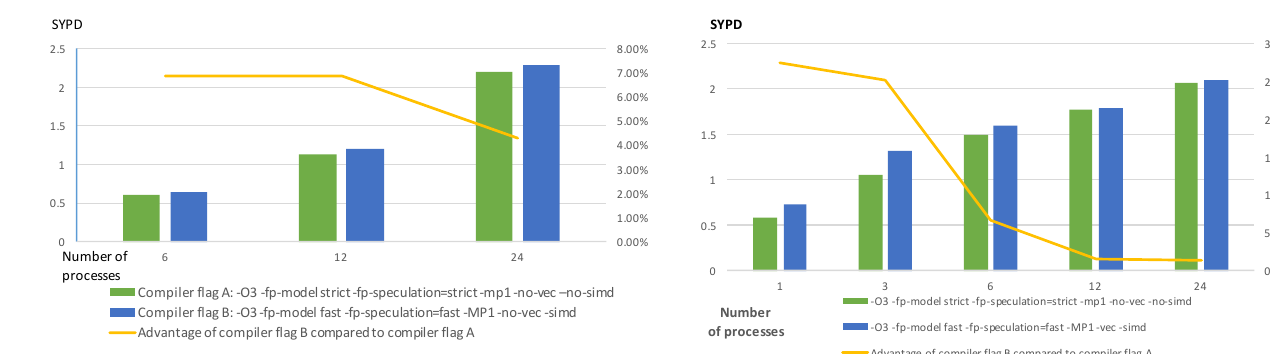
Figure 5. Simulation speed (simulated years per day; SYPD) of GAMIL2 (Li et al., 2013b) under two compiler flags (A and B) of Intel compiler version 13 when increasing the number of pro- cesses from 1 to 24. The high-performance computer Tansuo100 is used for this test. Compiler flag A ( -O3 -fp-model strict -fp- speculation=strict -mp1 -no-vec -no-simd ) is the also the compiler flag A used in Fig. 4. Compiler flag B ( -O3 -fp-model fast -fp- speculation=fast -MP1 -vec -simd ) should be the compiler flag for fastest simulation speed. The advantage of compiler flag B com- pared to compiler flag A is defined as the performance improvement when compiler flag is changed from A to